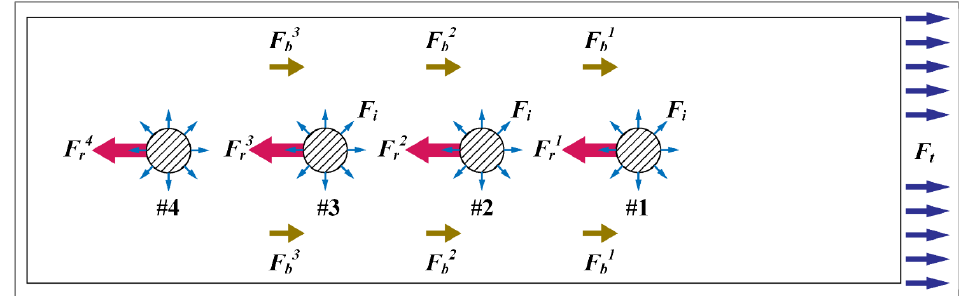
Figure 3. Schematic diagram of the force condition of multi-riveted interference fit joint. 𝐹 𝑟𝑖 represents the rivet load, 𝐹 𝑏𝑖 represents the bypass load, 𝐹 𝑖 represents the interference load, and #𝑖 represents the position of the rivet. 𝐹 𝑡 is the tensile load.